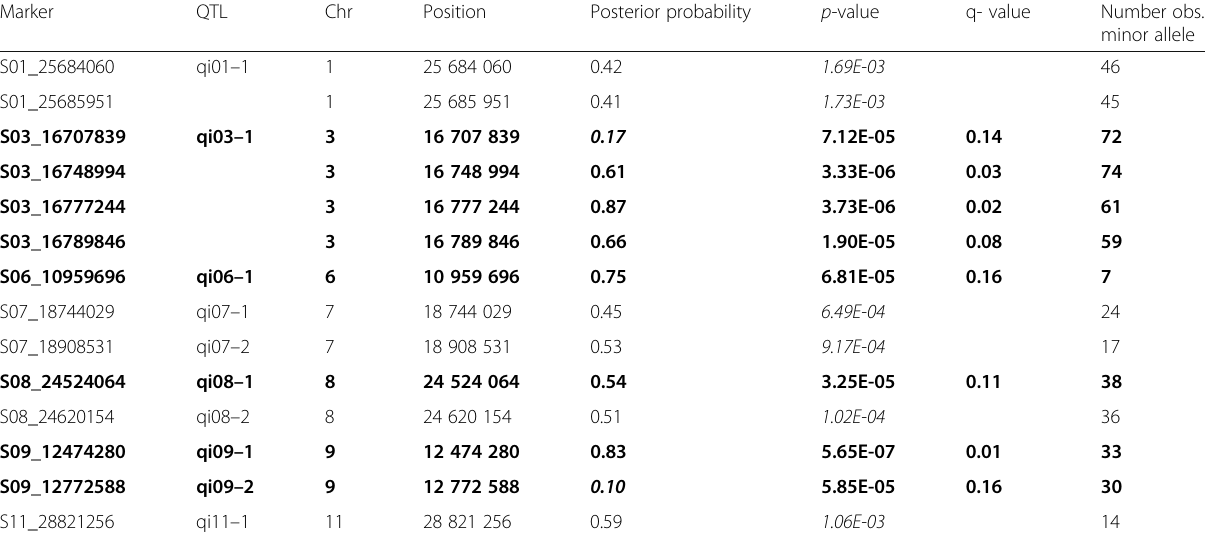
Table 3 Markers significant in the GBS indica